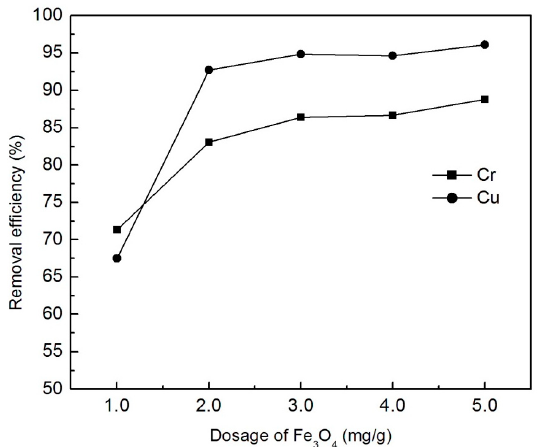
Figure 6. E ff ect of adsorbent dosage on the removal rate for Cr(VI) and Figure 6. Effect of adsorbent dosage on the removal rate for Cr(VI) and Cu(II).